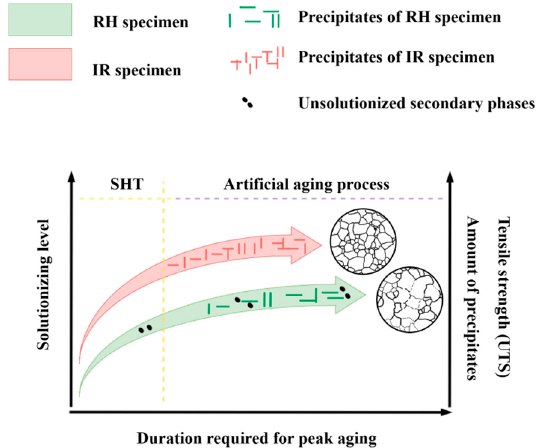
Figure 16. Schematic diagram of rapid heating process. Process can be applied to acquire larger amount of precipitates and slightly higher tensile strength.